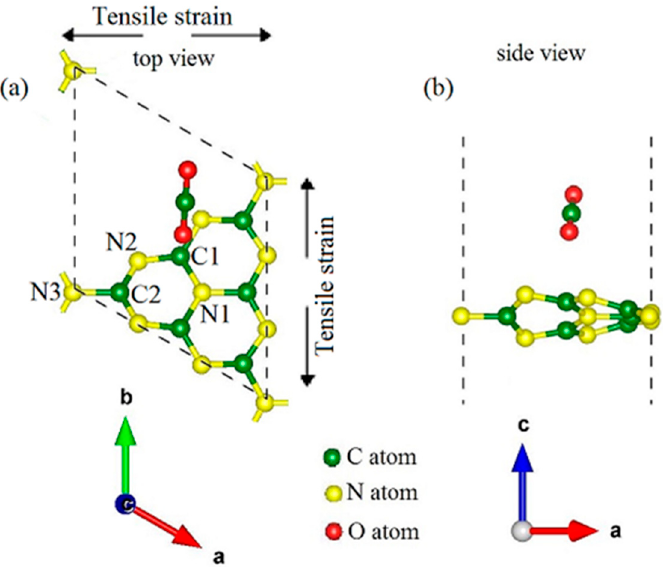
Figure 1. ( a , b ) are the top and side views of the optimized CO 2 adsorbed g-C 3 N 4 (without strain) system within the unit cell, respectively, which is represented by the dashed black parallelogram. The green, yellow and red balls represent C, N and O atoms, respectively. In addition, the orientation of biaxial tensile strain is signed with black arrows. For the pristine g-C 3 N 4 , there are three types of N and two types of C (N1, N2, N3, C1 and C2).